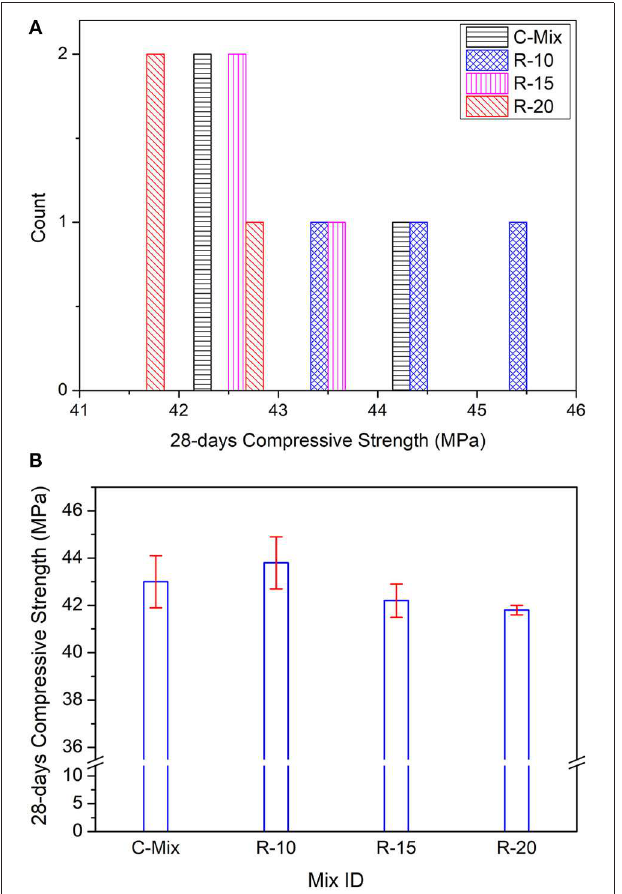
FIGURE 8 | (A) Histogram of compressive strength for all mixes, and (B) Comparison of their average 28 days compressive strengths with error bars.